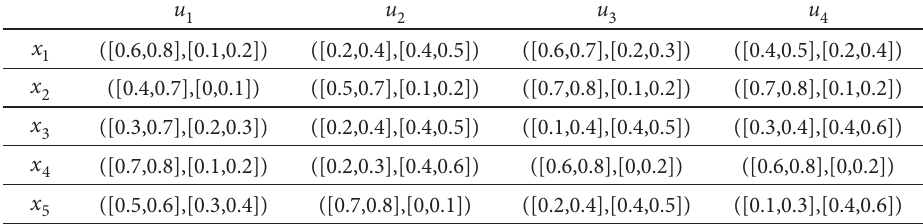
Table 3. Interval-valued intuitionistic fuzzy decision matrix